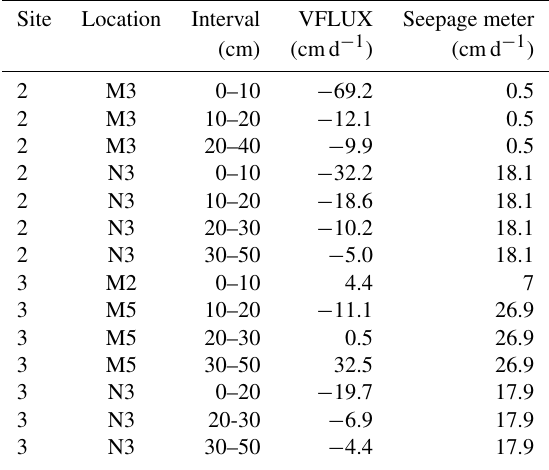
Figure 8. Seepage rates determined with VFLUX and Delaware River discharge determined over 25-day period from 28 June– 23 July. Table 2. Comparison of time-averaged VFLUX seepage values and median seepage-meter values at select